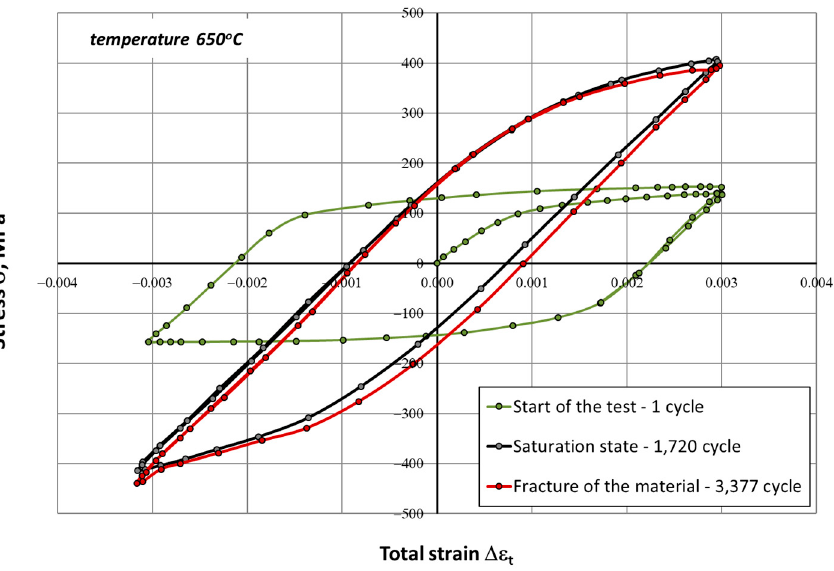
Figure 6. Hysteresis loops determined in a low-cycle fatigue test at 650 °C for the strain range ∆ε t = 0.6%.